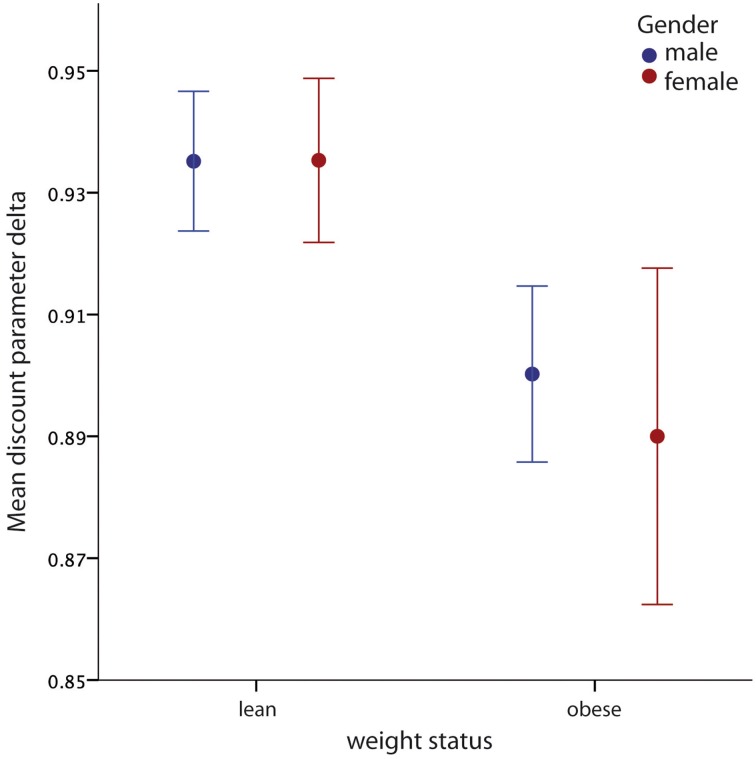
Main effect of obesity on delay discounting parameter δ. Obese subjects had lower values of the discounting parameter δ, independent of gender. Error bars indicate standard errors of means (SEM).